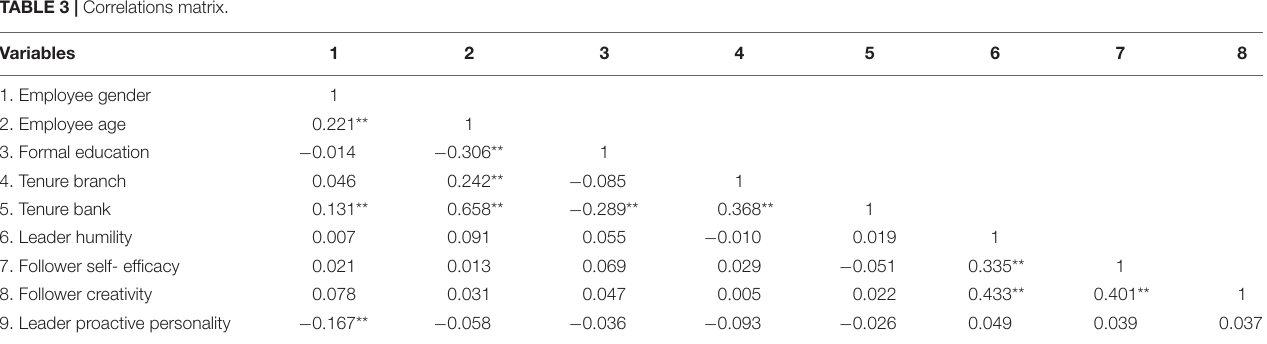
TABLE 3 | Correlations matrix.